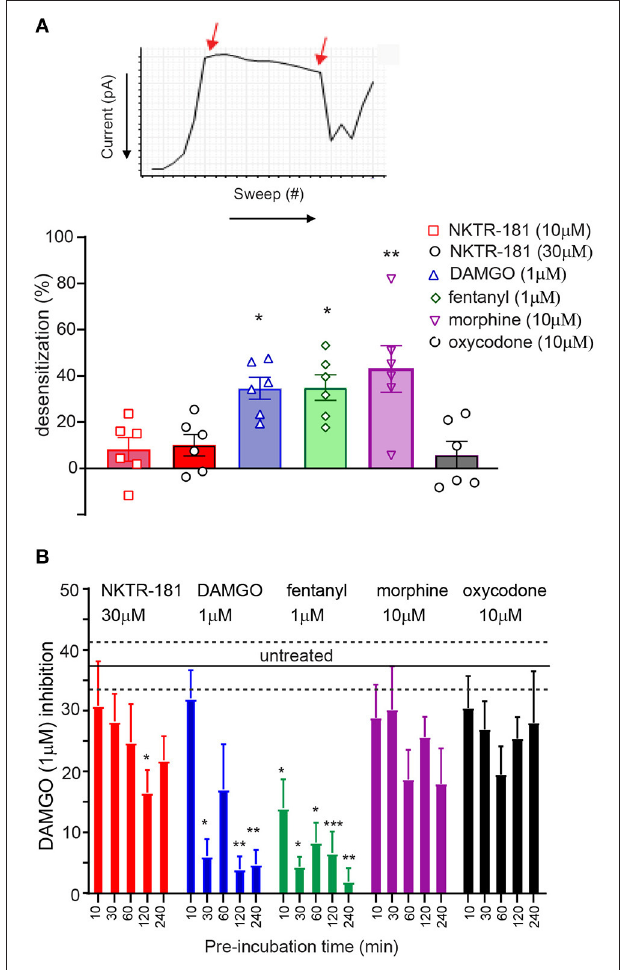
FIGURE 3 | NKTR-181 results in minimal desensitization of MOPr-VACC inhibition. (A) Rapid desensitization. (A) VACC inhibition by mu agonists desensitizes over time, as shown by the decrease in current when the agonist is continuously perfused and the loss of inhibition assessed with each sweep, as shown by the two arrows 2 ′ apart. (A) These recordings were obtained following the application of each agonist and show that DAMGO, fentanyl, and morphine, but not NKTR-181 or oxycodone, induce desensitization; *, **, p < 0.05, and 0.01, respectively, vs. NKTR-181 30 µ M. (B) Chronic desensitization : VACC inhibition by MOPr agonists also desensitizes the following periods of longer agonist exposure. In this assay, DRG neurons were pre-incubated with different agonists for increasing periods of time and doses. The agonists were then washed off and VACC inhibition assessed by 1 µ M DAMGO to define MOPr-VACC inhibition compared with that of untreated cells. DAMGO and fentanyl desensitized MOPr-VACC inhibition over time. NKTR-181 induced limited desensitization after 2h of pre-incubation and morphine and oxycodone resulted in no desensitization. *, **, and *** p < 0.05, 0.01 and 0.001 vs. untreated, respectively. Data are shown as mean Refer to Supplementary Table 2 for